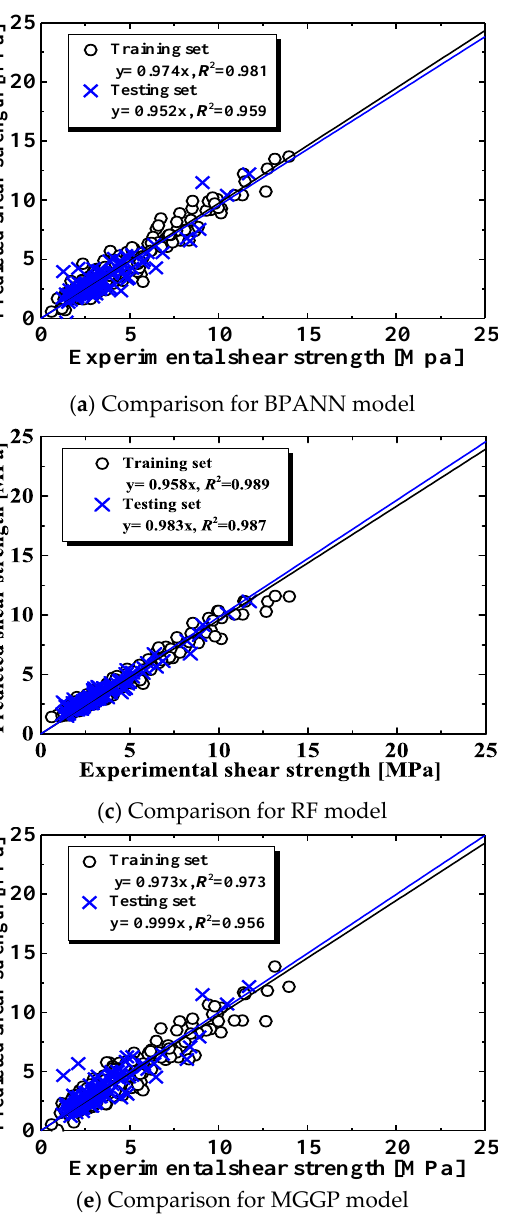
Figure 6. Comparisons between experimental results and predictions using AI models.